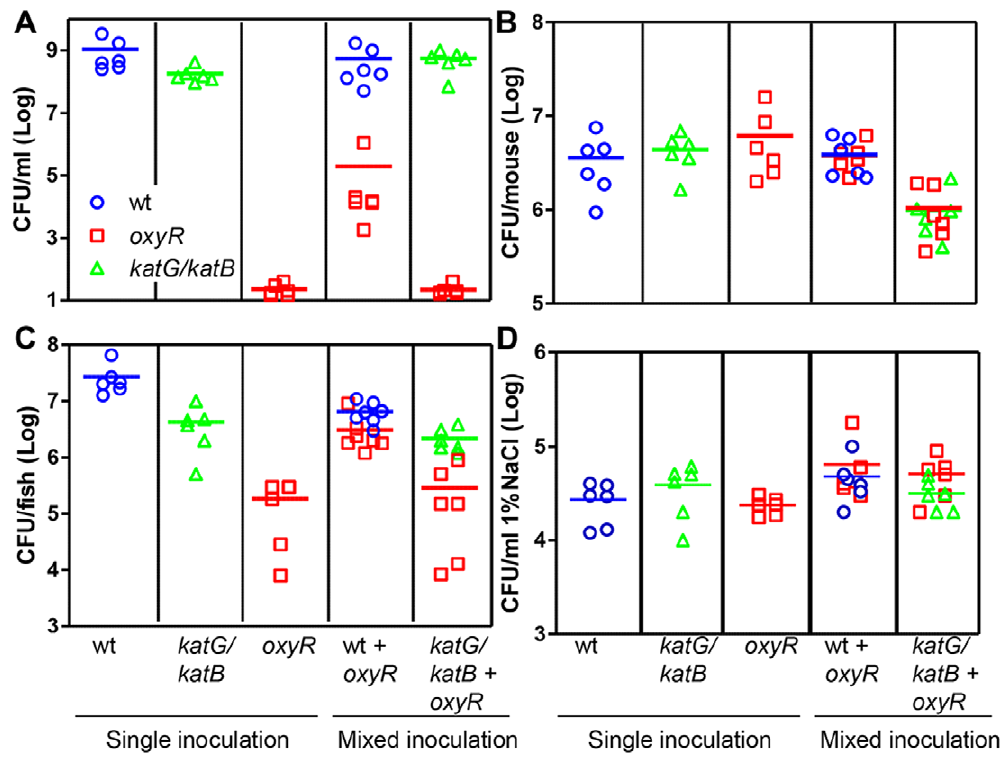
Figure 6. The effect of co-culturing catalase-positive and catalase-negative cells on oxyR growth in different environments. A. Overnight cultures of wildtype (circles), katG-katB (triangles), and oxyR mutants (squares) were inoculated alone or together at 1:1000 into fresh LB medium and shaken at 37 u C for 8 hrs. CFU of live cells were then determined by serial dilution and plating on LB agar plates containing appropriate antibiotics and 0.5 m M purified KatG. A spontaneous rifamycin-resistant oxyR mutant was used to facilitate selection. Each symbol represents CFU from one culture. B. Approximately 10 6 single or mixed cells indicated were intragastrically inoculated into 6-day-old CD-1 mice. After 18-hr incubation, bacterial numbers colonized in small intestines were determined as described in A. The data shown are from three independent experiments and each symbol represents CFU recovered from one mouse intestine. C and D. 3-month old zebrafish were placed in 1% NaCl water containing approximately 10 4 /ml of bacterial cells indicated for 24 hrs. The zebrafish intestines were removed after surface sterilization by 70% ethanol and the colonization of fish intestines was determined as described in A and reported in C. The number of bacteria in the salt water was determined as described in A and reported in D. The data shown are from three independent experiments and each symbol represents CFU recovered from one fish intestine (C) or recovered from one container of salt water containing zebrafish (D).